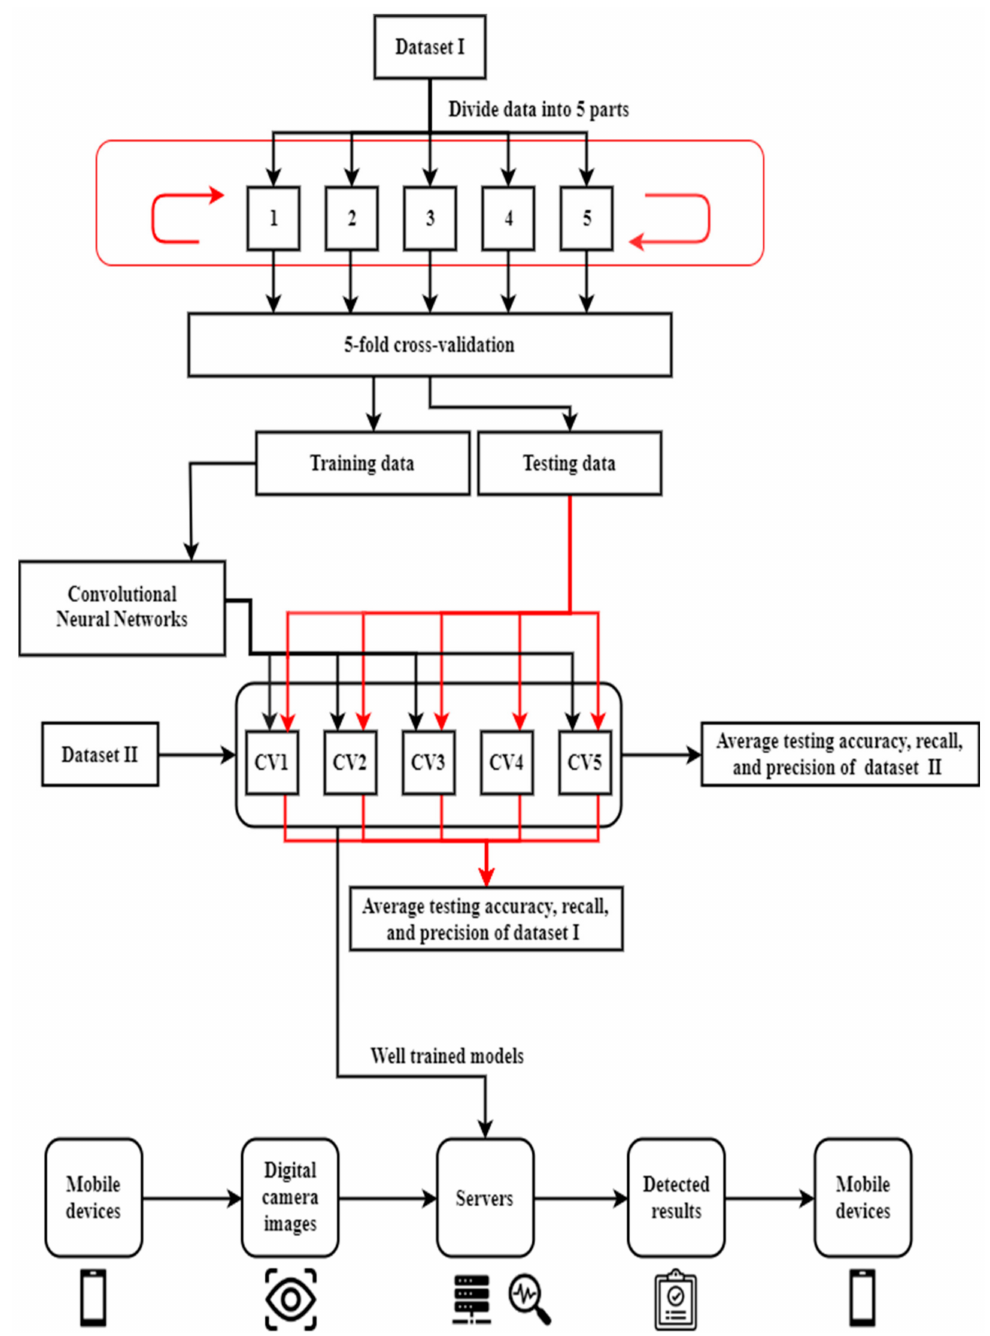
Figure 1. The architecture of the proposed CNNDCI system. Table 1. The numbers of data in each partition for dataset I with fivefold